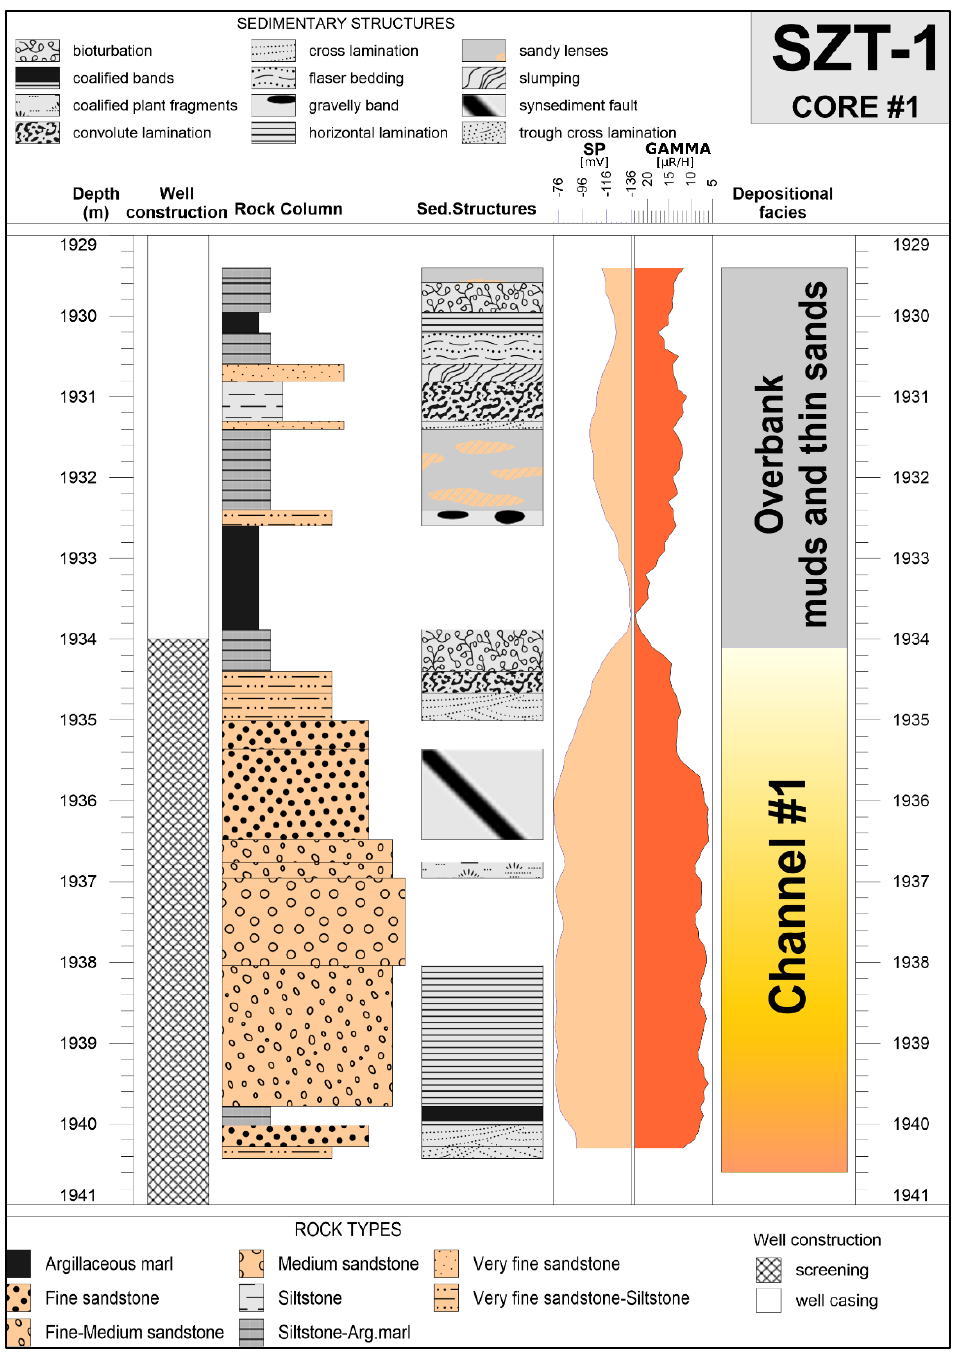
Figure 8. Representative lithofacies characterisation of core samples collected from well SZT-1 (modified after [30]].